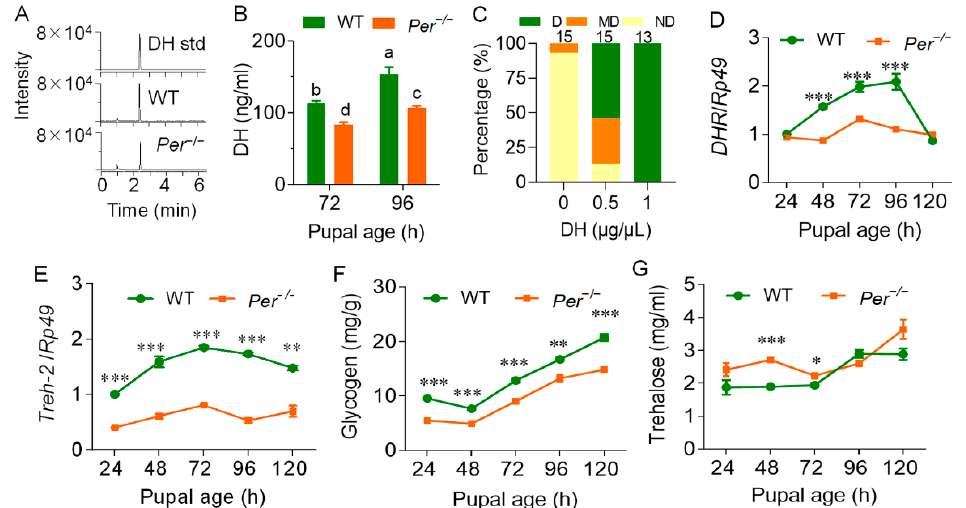
Figure 3. Per -knockout affects the DH content and the diapause metabolism of the female pupal hemolymph. The parental silkworm eggs were incubated at 25LD, and the larval and pupal stage maintained a 25LD environment. ( A ) DH mass spectrum. DH std, standard product of DH; WT and Per − / − represents the 72 h pupal hemolymph of wild-type and mutant silkworm, respectively. ( B ) DH content in pupal hemolymph. In the multiple comparison of significant differences in the figure, there is no significant difference between the same letters, and there are significant differences between different letters ( p ≤ 0.05, n = 3). ( C ) The diapause rescue effect of DH supplementation by female pupae on the eggs laid by mutant adults ( n = 13–15 batches). The parental eggs were incubated at 25LD, and the pupa was injected 10 µ L DH at age 72 h ( ± 2 h). DH concentration ( w : v ) was 0.5 µ g/ µ L and 1.0 µ g/ µ L. The control was injected with the same volume of sterile water. The transcription levels of DHR ( D ) and Treh-2 ( E ) in the pupal ovaries were measured by qRT-PCR and with the reference gene was Rp49 ( n = 3). ( F ) Glycogen content in the ovary ( n = 4). ( G ) The content of trehalose in hemolymph ( n = 6). In Figure ( B – G ), data were expressed as the mean ± SEM, the difference between Per − / − and WT is: *, p < 0.05; **, p < 0.01; ***, p < 0.001.